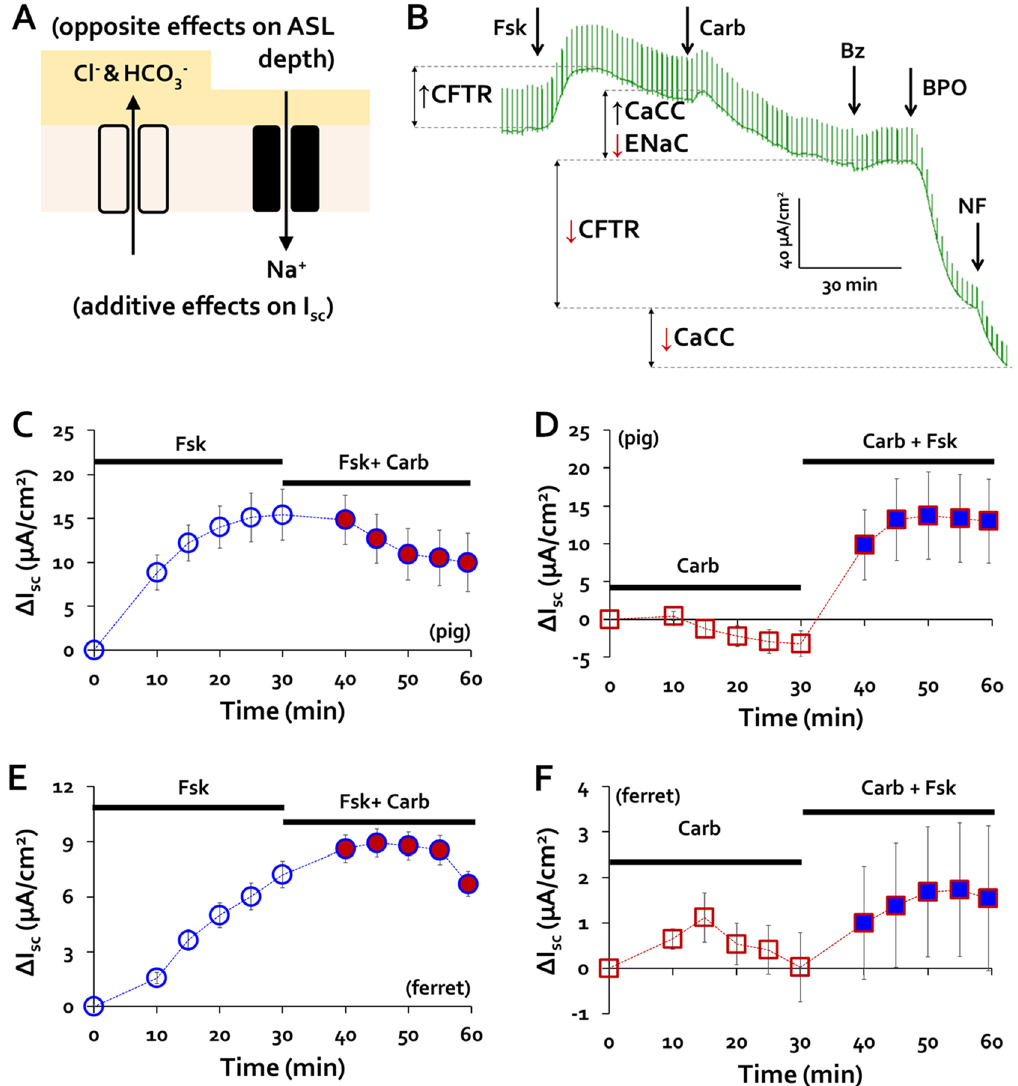
Figure 4. Combined agonists inhibit sodium absorption and stimulate anion secretion by surface epithelia. ( A ) Cartoon of two electrogenic, ion transport pathways across airway apical epithelium: anion secretion increases surface fluid, Na + absorption decreases surface fluid. The two pathways have opposite effects on fluid height, but additive effects on I sc because of their opposite valence and transport directions. ( B ) Raw trace of I sc across pig tracheal epithelium using Chart 4 software. After reaching a stable, unstimulated I sc (here, > 2 h post-mounting), 10 µM forskolin, 0.3 µM carbachol, 10 µM benzamil, 20 µM benzopyrimido-pyrrolo-oxazinedione (BPO- 27) and 200 µM niflumic acid were sequentially added at times shown (see text). ( C,D ) Pig tracheal mucosa: averaged ΔI sc plots over time in response to ( C ) forskolin alone followed by forskolin + carbachol and ( D ) reversed order of agonist addition. ( E & F ) Ferret tracheal mucosa: averaged ΔI sc plots with same protocol as for pigs. Pig traces ( C,D ) are based on 10–12 experiments with tissues from 6 to 7 pigs. Ferret traces ( E,F ) are from 7 experiments with tissues from 5